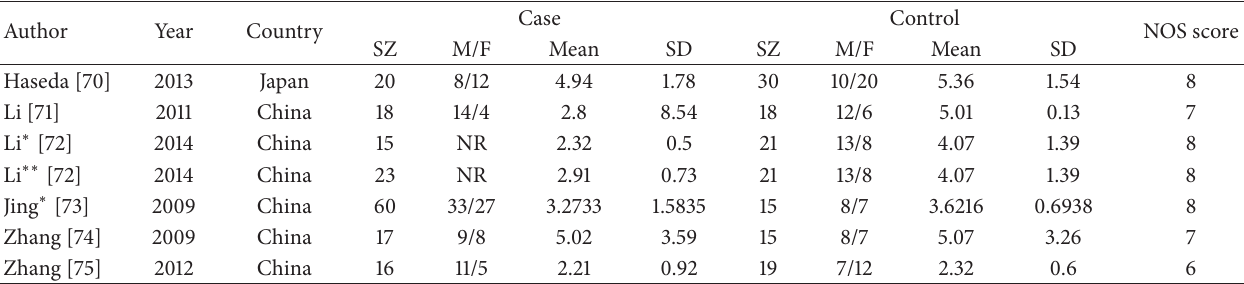
Table 4: Characteristics of studies about the percentage of CD4 + CD25 + Foxp3 + Tregs (%) in the CD4 + lymphocyte included in this meta- analysis.